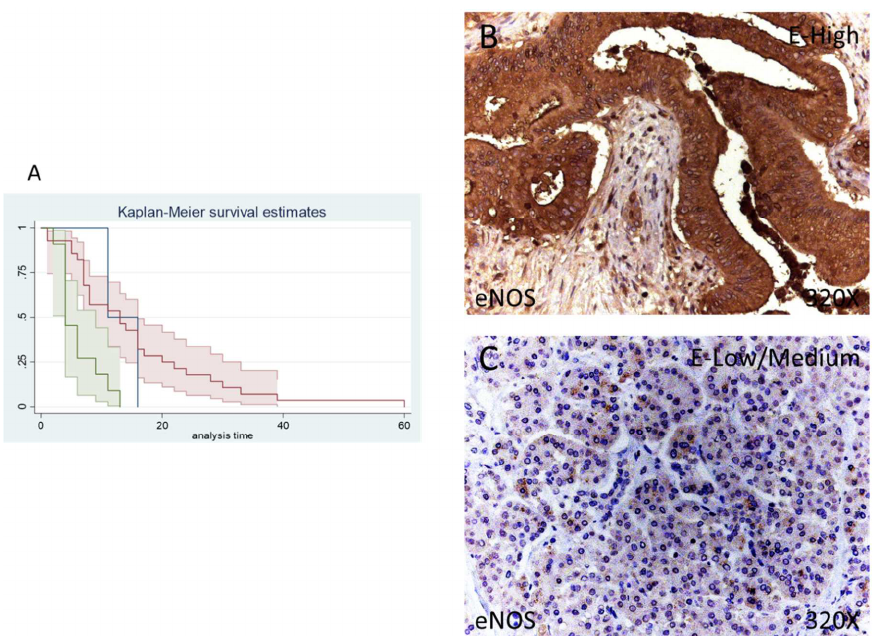
Figure 4. ( A ) Kaplan–Meier curves for survival time according to tumor expression of eNOS. Blue curve = tissue expression classified as negative, red curve = tissue expression classified as low/medium, green curve = tissue expression classified as high. ( B , C ) Images showing the protein expression of eNOS in patients diagnosed with pancreatic cancer. Finally, only 1 patient (2.44%) was negative for iNOS expression, whereas 13 (31.71%) were low/moderate for iNOS and 27 (65.85%) presented a high iNOS expression, accord- ing to our immunohistochemical data. (Figure 5B,C).